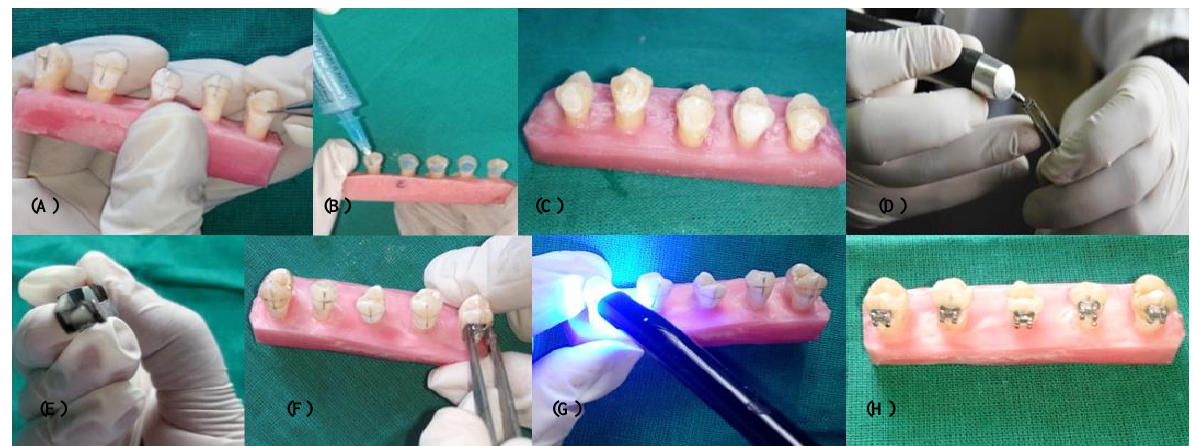
Fig. 1. Procedure of direct bonding on the labial surface of the tooth. (A) Horizontal and vertical pencil marks for ideal bracket positioning. (B) Application of etchant gel. (C) White frosty appearance of the enamel surface after etching. (D) Application of Transbond adhesive and primer on the bracket base. (E) Placement of bracket with bracket holding tweezer on the tooth. (F) Curing of the bracket on the tooth surface. (G) Sample